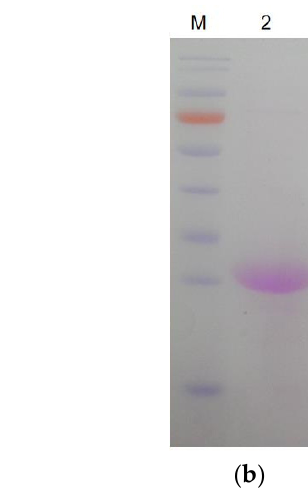
Figure 1. SDS-PAGE of the purified native Ta AA9A. n Ta AA9A was visualized ( a ) by staining with Coomassie Brilliant Blue; ( b ) by staining with the Pierce™ Glycoprotein Staining Kit. Lane M, protein markers (kDa); Lanes 1 and 2, n Ta AA9A.